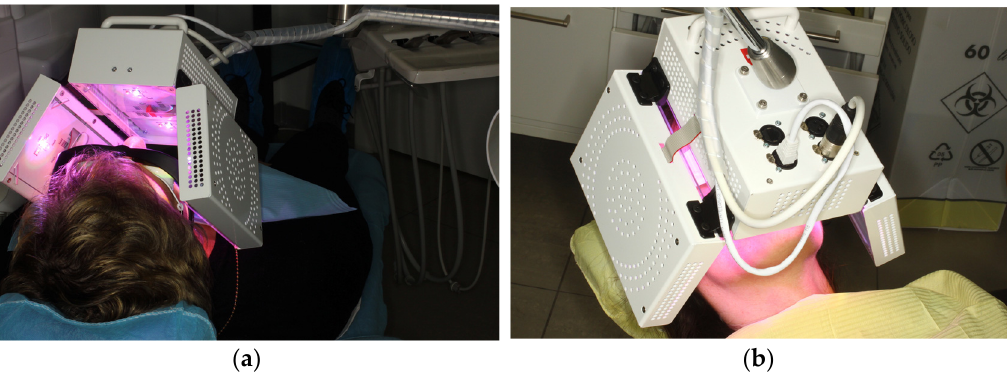
Figure 3. ( a , b ) LED photobiomodulation with